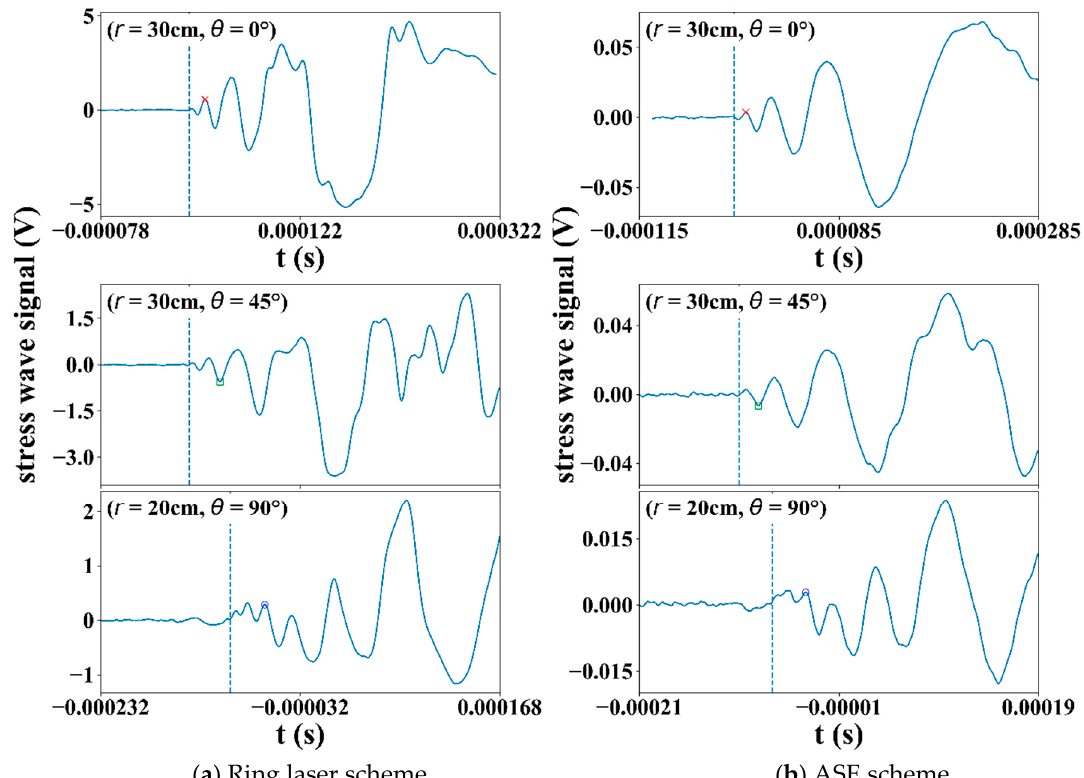
Figure 6. Stress wave received using: ( a ) the ring laser scheme; ( b ) the amplified spontaneous emission scheme when impacts were made at different ( r , θ )’s. Note that for each scheme, signals for θ = 45° and 90° were from the same impact event.